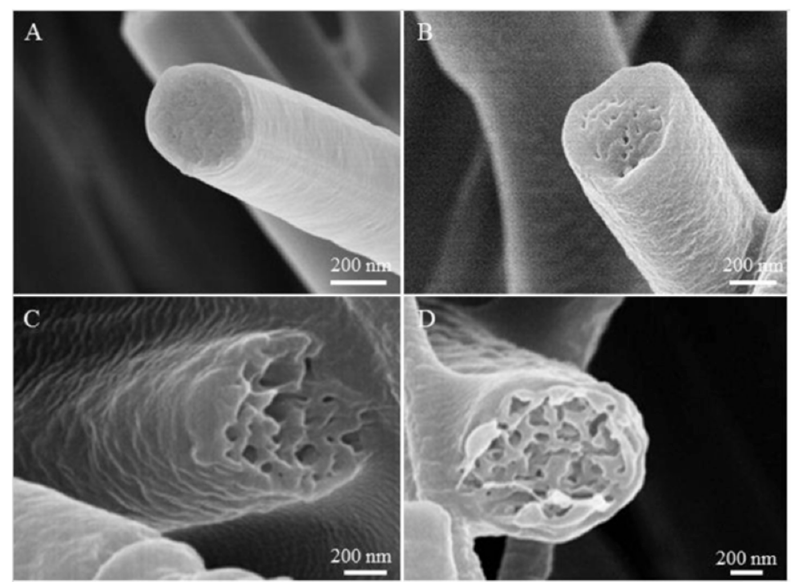
Figure 9. Cross-sectional SEM images of samples fabricated by electrospinning 35% ( w / v ) PVDF solution from DMF at different levels of relative humidity ( A ) 5%, ( B ) 25%, ( C ) 45%, and ( D ) 65%. Reprinted with permission from [96].